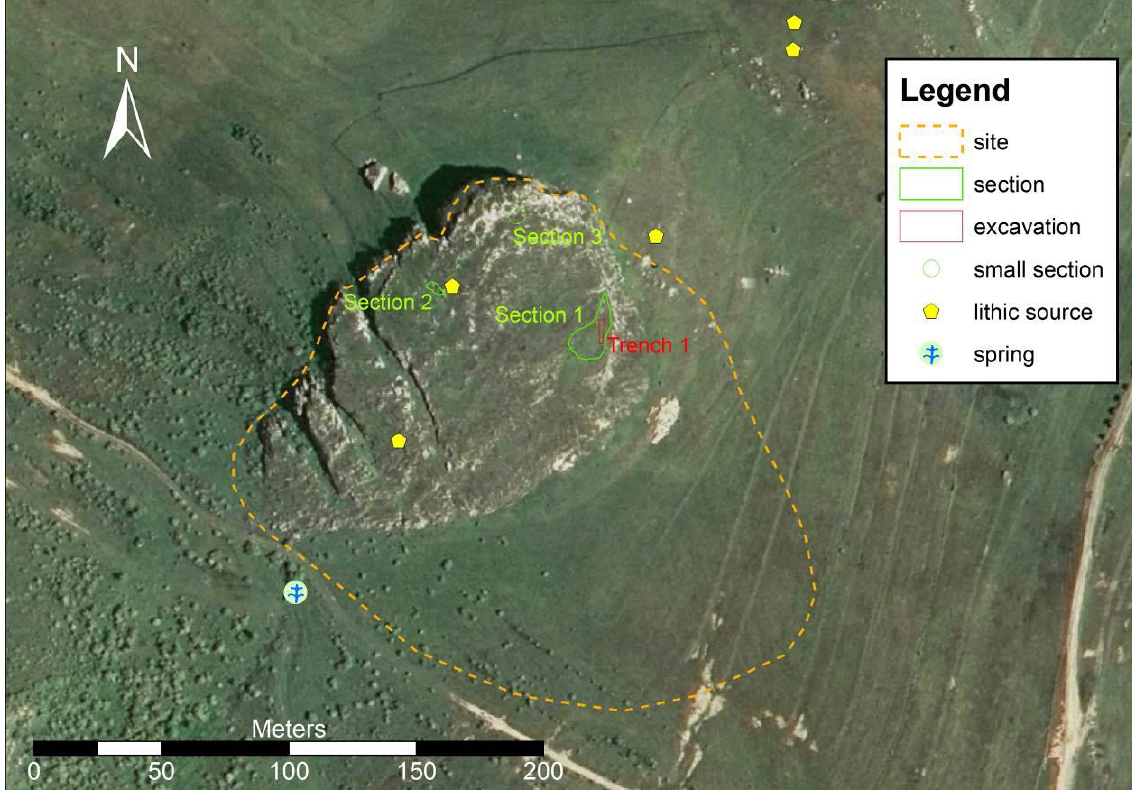
Figure 4. Aerial view of the Piatra Tomii archaeological site around the hill. (Aerial photo from ANCPI orthophoto